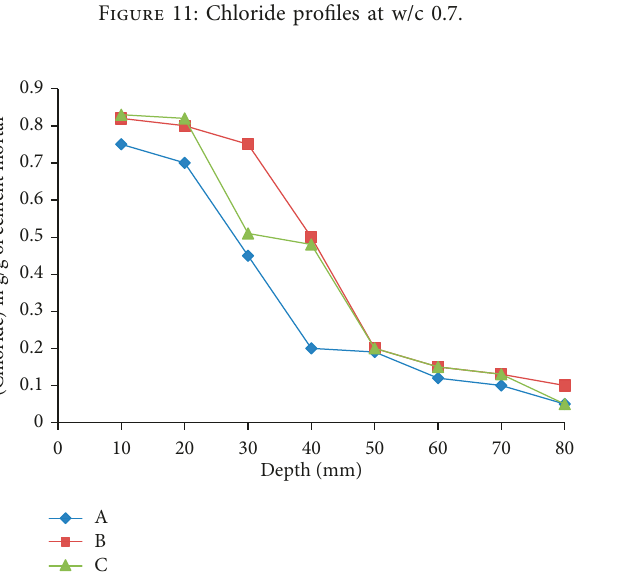
Figure 11: Chloride profiles at w/c 0.7.